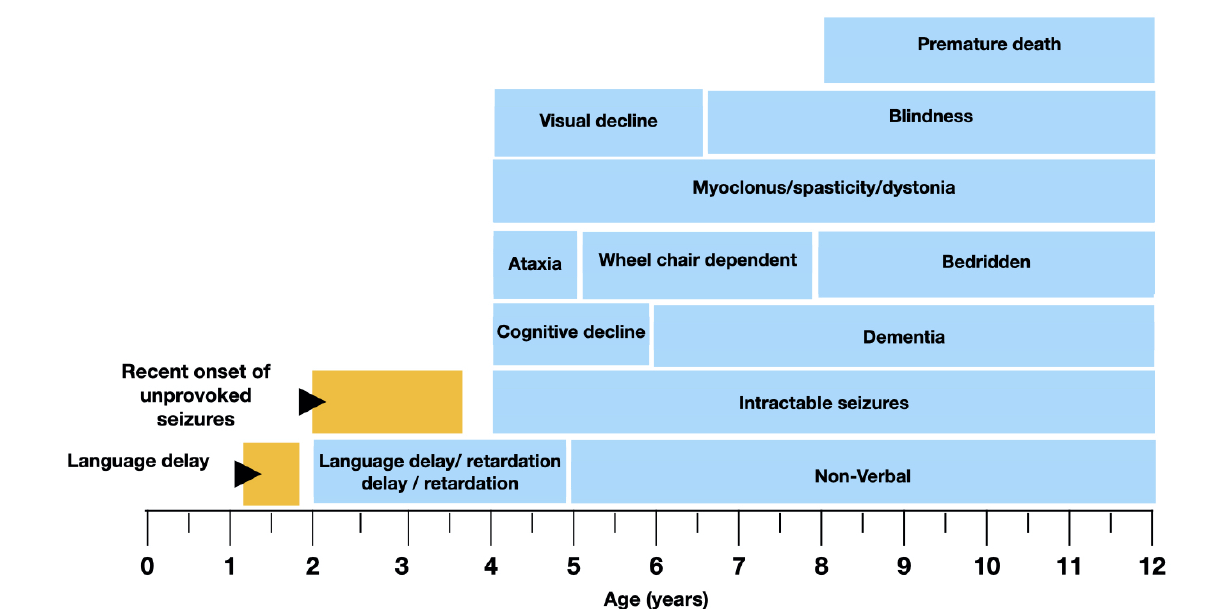
Figure 1. Symptom onset timeline. Taken from https://www.cln2connection.com/es-co/overview/natural-history/.